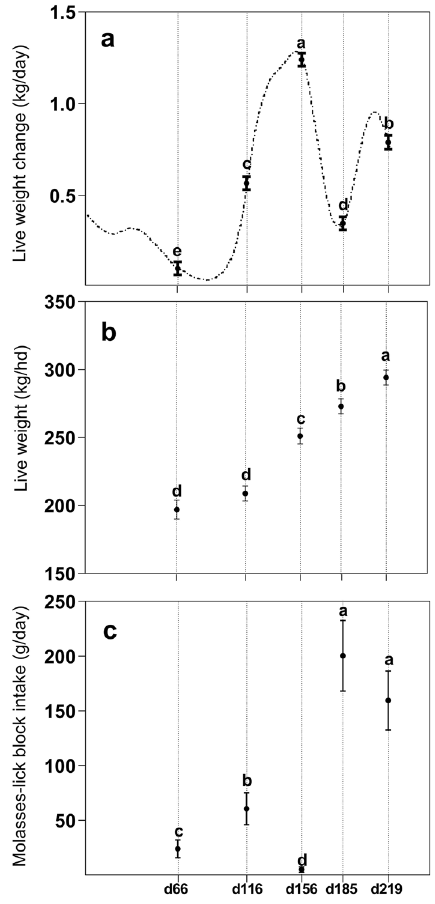
Figure 1. ( a ) Daily live weight change ( b ) Live weight measured with an automatic weighing system and ( c ) molasses-lick block intake of grazing weaner cattle over time. Continuous line in panel ( a ) indicates the average live weight change (LWC) of the